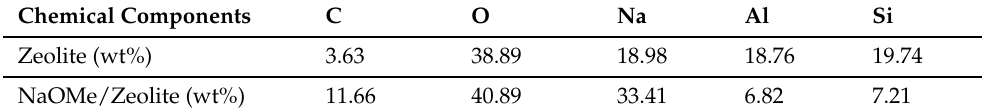
Table 2. Elemental analysis of raw zeolite and synthesized NaOMe/Zeolite catalyst.